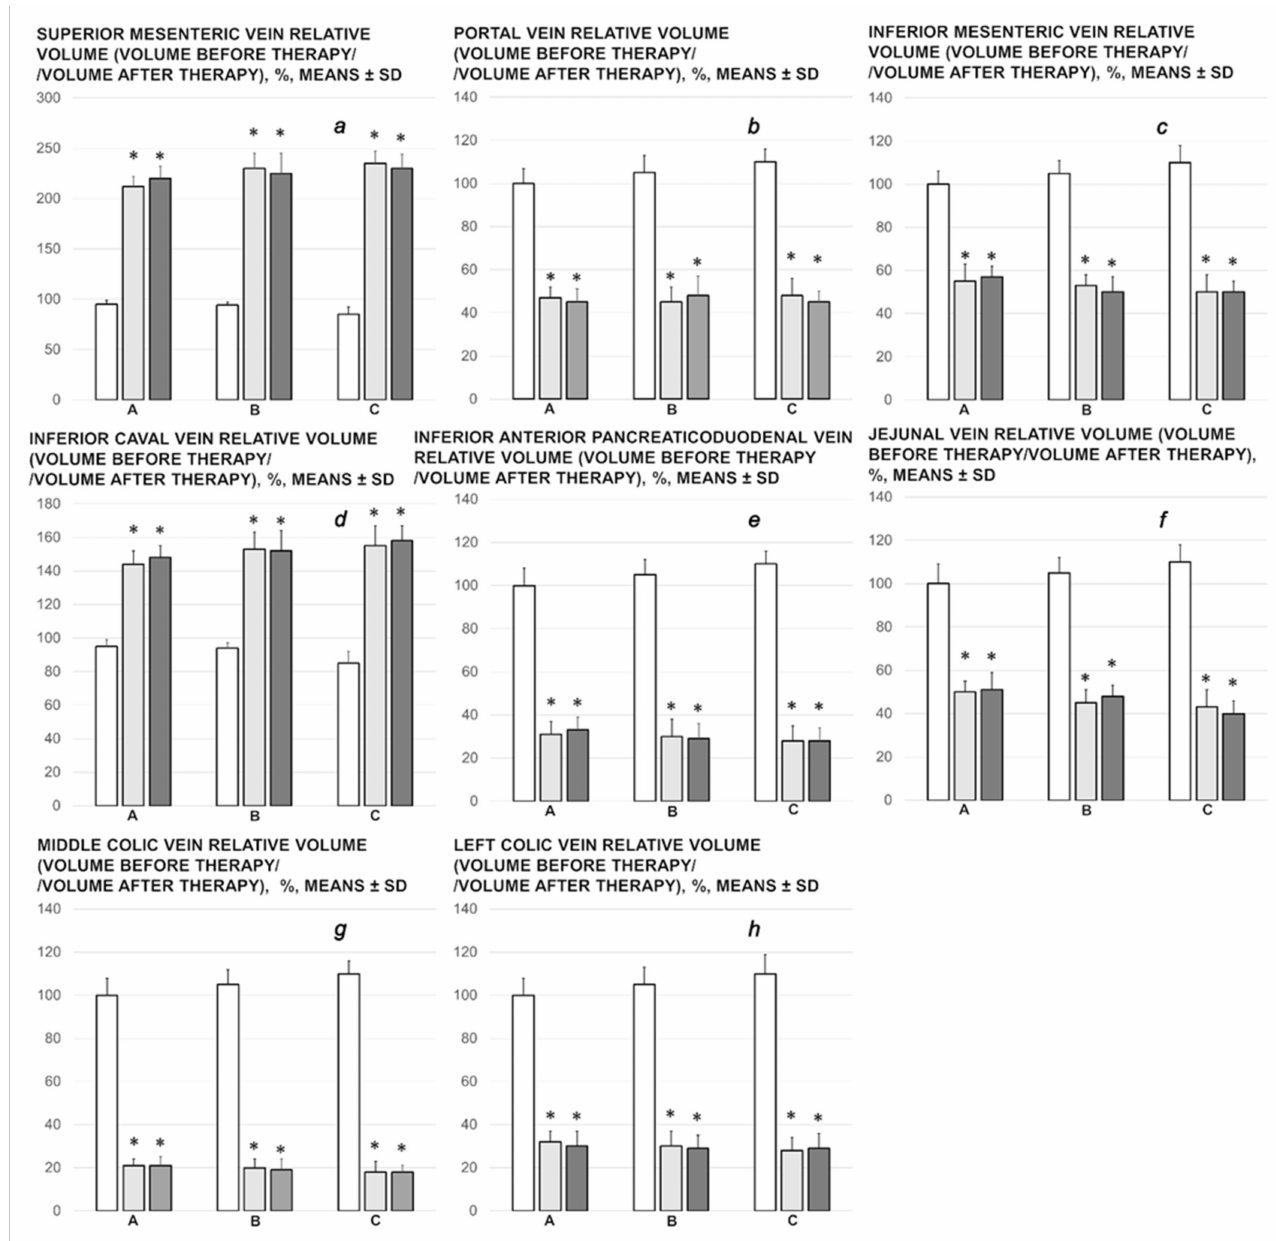
Figure 2. Relative volume of the veins ( a – h ) (superior mesenteric vein ( a ), portal ( b ), inferior mesenteric vein ( c ), inferior caval vein ( d ), inferior anterior pancreaticoduodenal vein ( e ), jejunal ( f ), middle colic vein ( g ), and left colic vein ( h )), volume before therapy/volume after therapy, %, in the rats with ligated superior mesenteric vein, at 5 min (A), 15 min (B) and 30 min (C) ligation time. BPC 157 10 µ g/kg (light gray bars), 10 ng/kg (dark gray bars); saline 5 mL/kg (white bars) given intraperitoneally at 1 min ligation time. Six rats/group/interval. Means ± SD, * p < 0.05, at least, vs.